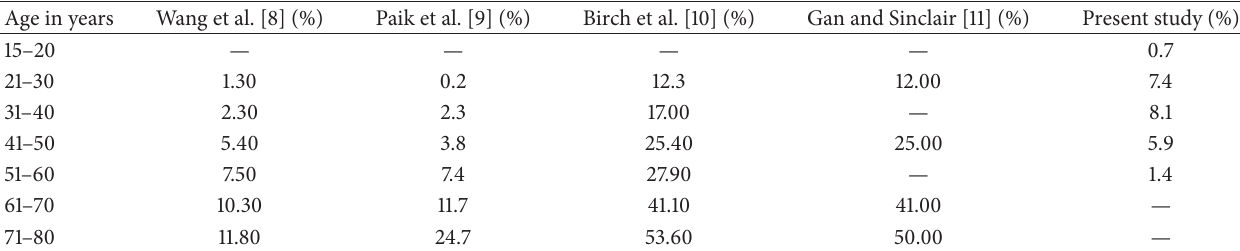
Table 4: Comparison between prevalence of female pattern hair